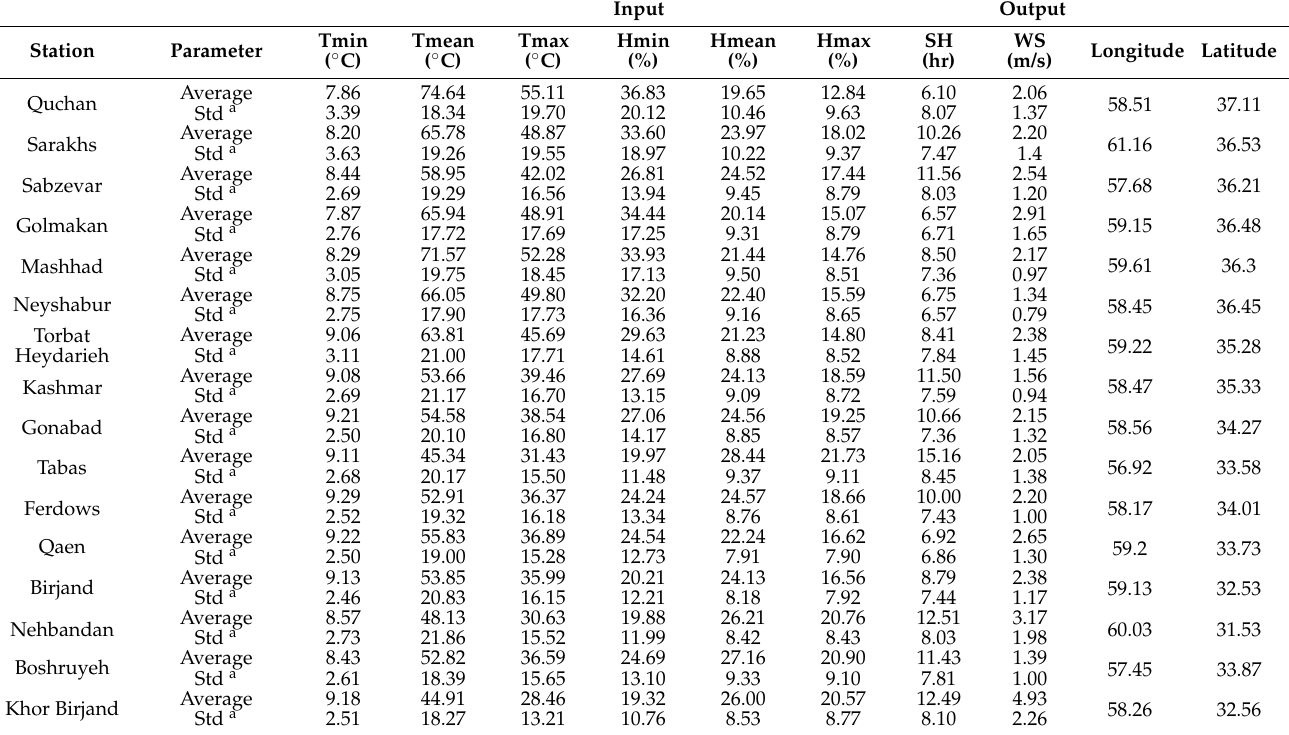
Table 1. Geographic information and statistical specifications of the data from the different stations. Input